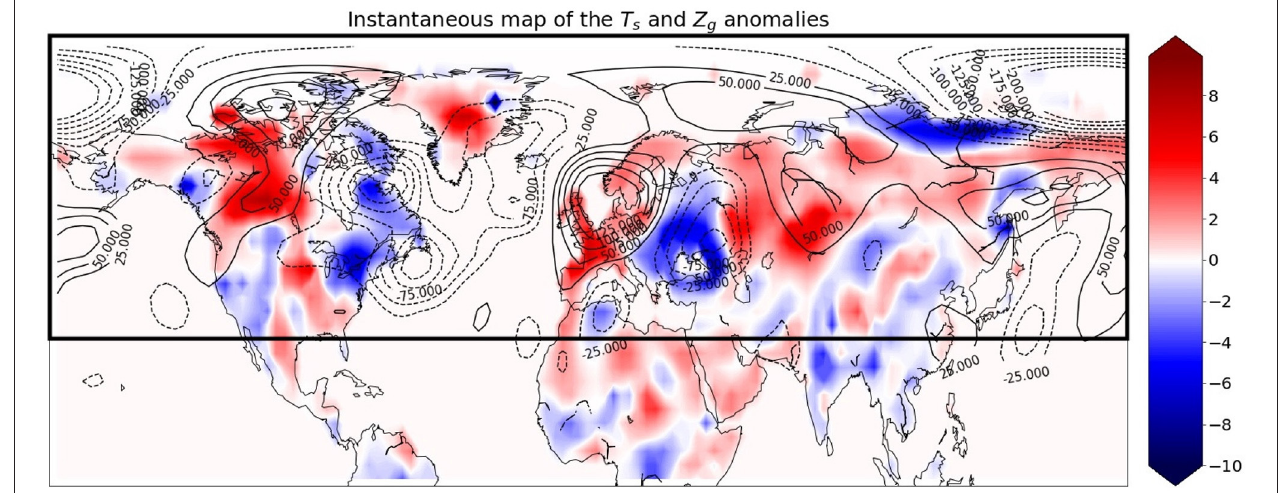
FIGURE 1 | Snapshot of the surface temperature surface fluctuations ( T s fluctuations, according to the color bar, in Kelvin) and of the geopotential height at 500mbar ( Z g fluctuations, contours) over the Northern Hemisphere. This snapshot is taken on July 20 th on a arbitrary year of the PlaSim simulation. The spatial resolution is 64 × 128 (latitude × longitude). The thin contour lines, representing the anomaly of Z g , are in meters. The thick black contour delimits the zone that is used for prediction by the machine learning